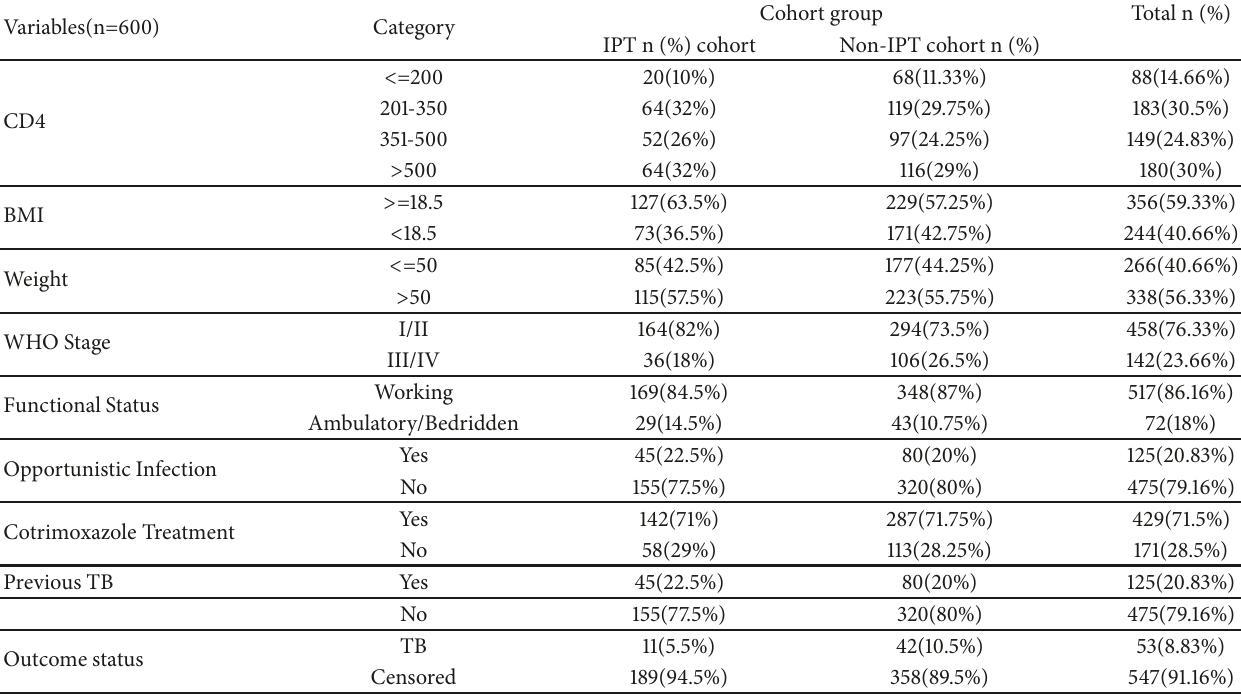
Table2:Baselineclinical,laboratoryresults,andfollowupoutcomecharacteristicsofPLWHatNekemtereferralhospitalandNekemteHealth center followed from September 2009-September